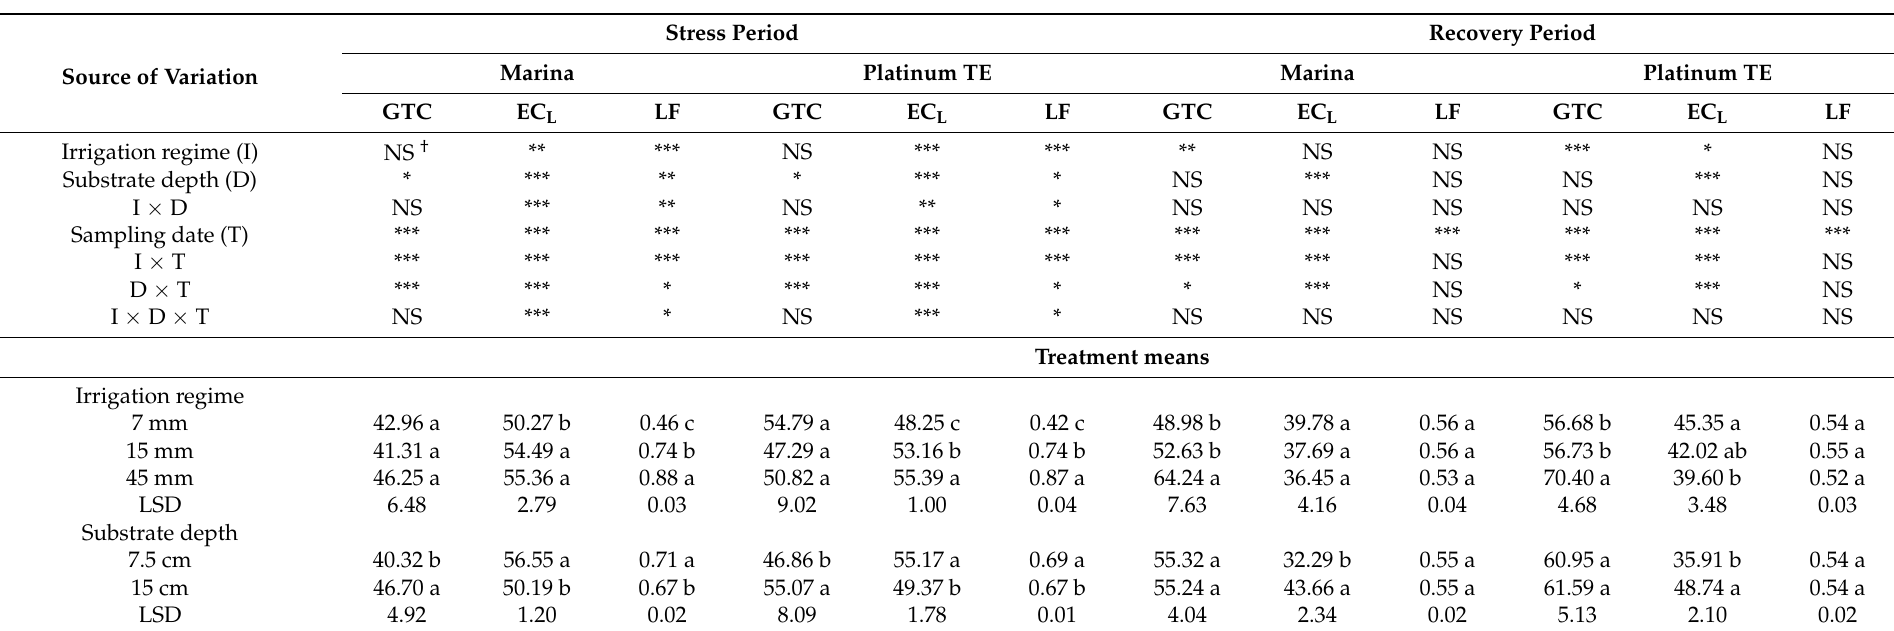
Table 3. Results of analysis of variance and table of means for green turf cover (GTC), leachate electrical conductivity (EC L ), and leaching fraction (LF) of the two Paspalum vaginatum varieties “Marina” and “Platinum TE”, across three seawater irrigation regimes (7 mm, 15 mm, and 45 mm) and two green roof substrate depths (7.5 cm and 15 cm), following the repeated measures analysis, with irrigation regimes being the main plot, substrate depths the subplot, and time (sampling dates) the sub-subplot. Means derive from pooled data over the whole salinity stress period (29 July–13 September 2016) or the recovery period (15 September–31 October 2016). Means in columns followed by the same letter are not significantly different at p < 0.05 using Fisher’s least significant difference